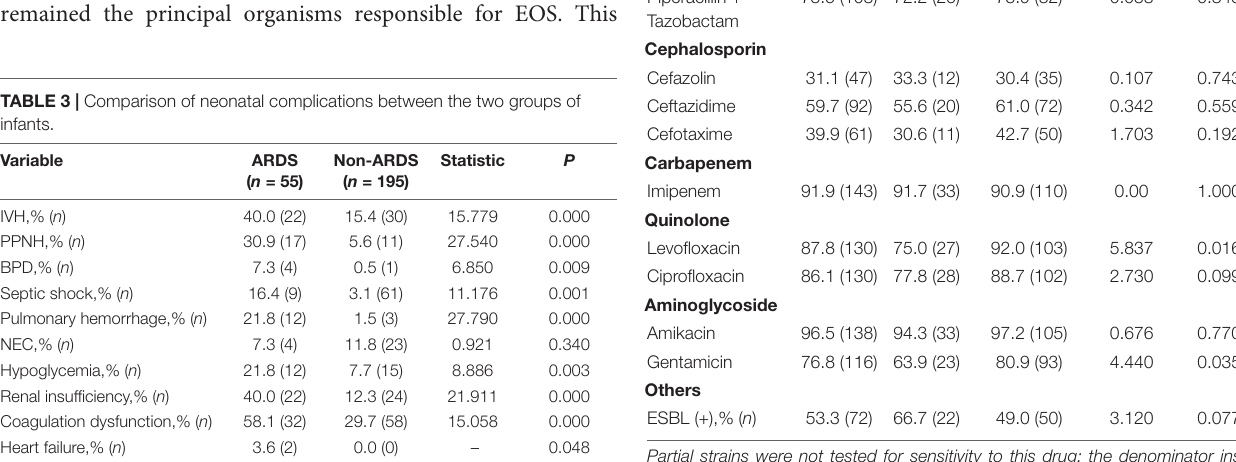
Partial strains were not tested for sensitivity to this drug; the denominator inside parentheses comprises the actual bacterial strains tested for sensitivity to this drug. ESBL: extended-spectrum β